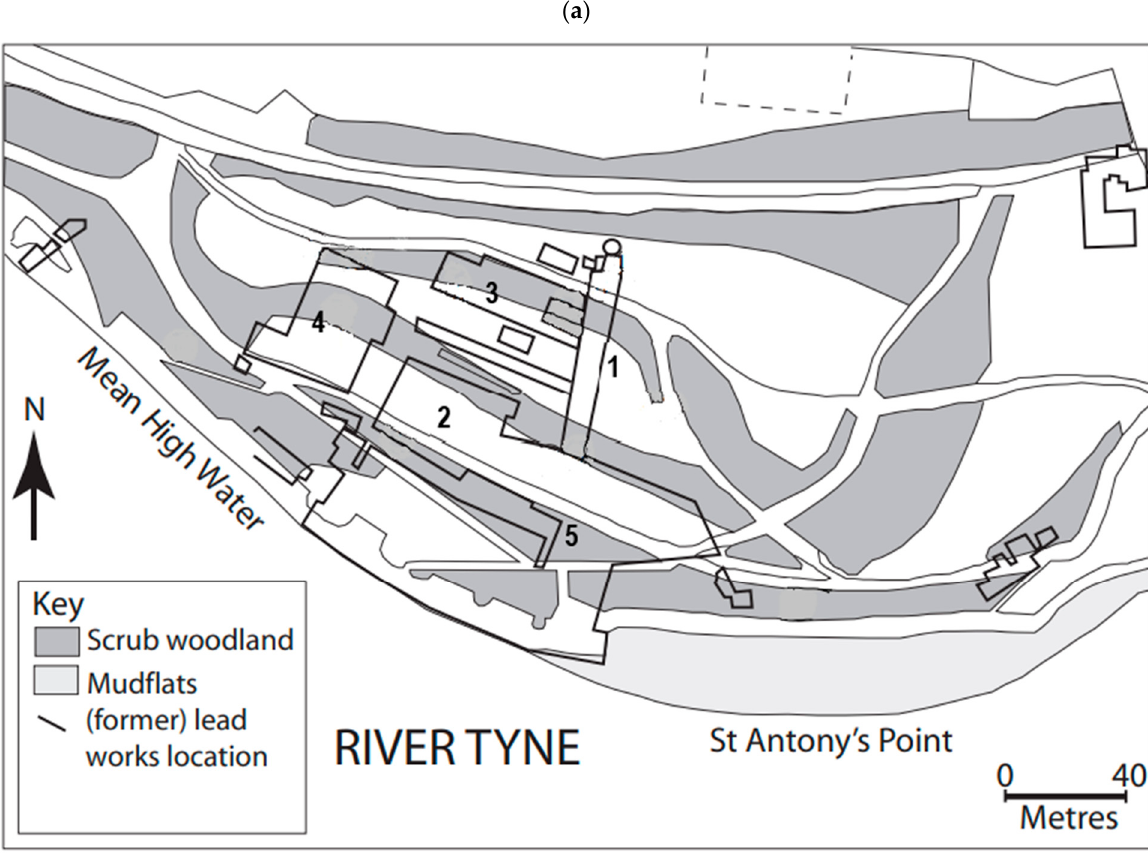
Figure 1. Walker Riverside Park ( a ) location of the sampling areas (A–H), and ( b ) historic location of the Lead Works, superimposed on the site. 1. Main chimney, 2. Rolling mill, 3. Furnaces, 4. Storage, and 5. Refining.